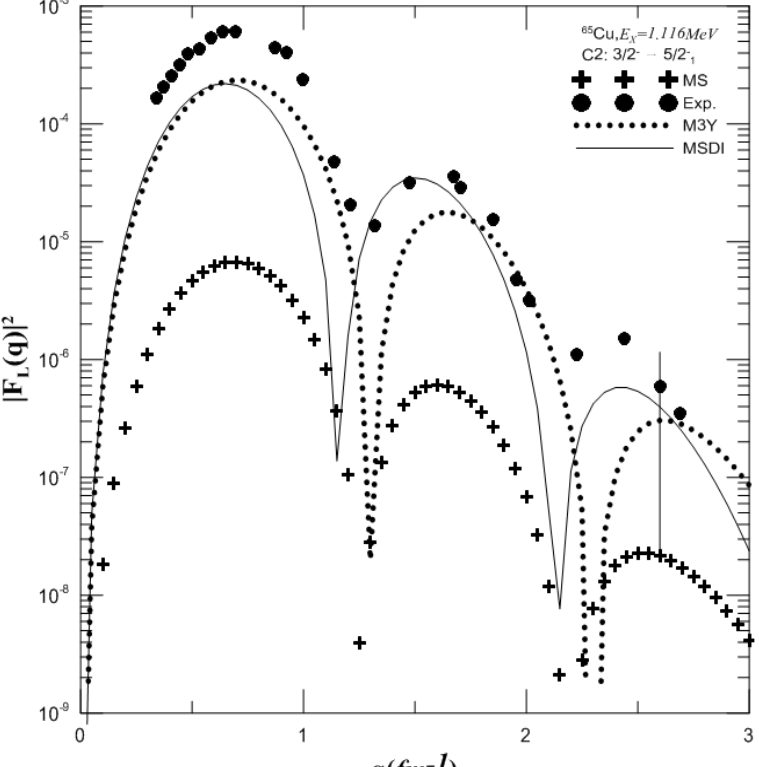
Fig.5: Inelastic longitudinal form factors for C2 transition 3/2 -  using MSDI and M3Y interactions with core-polarization effects, through particle-hole excitations up to 6ћω. The experimental data are taken from Ref.